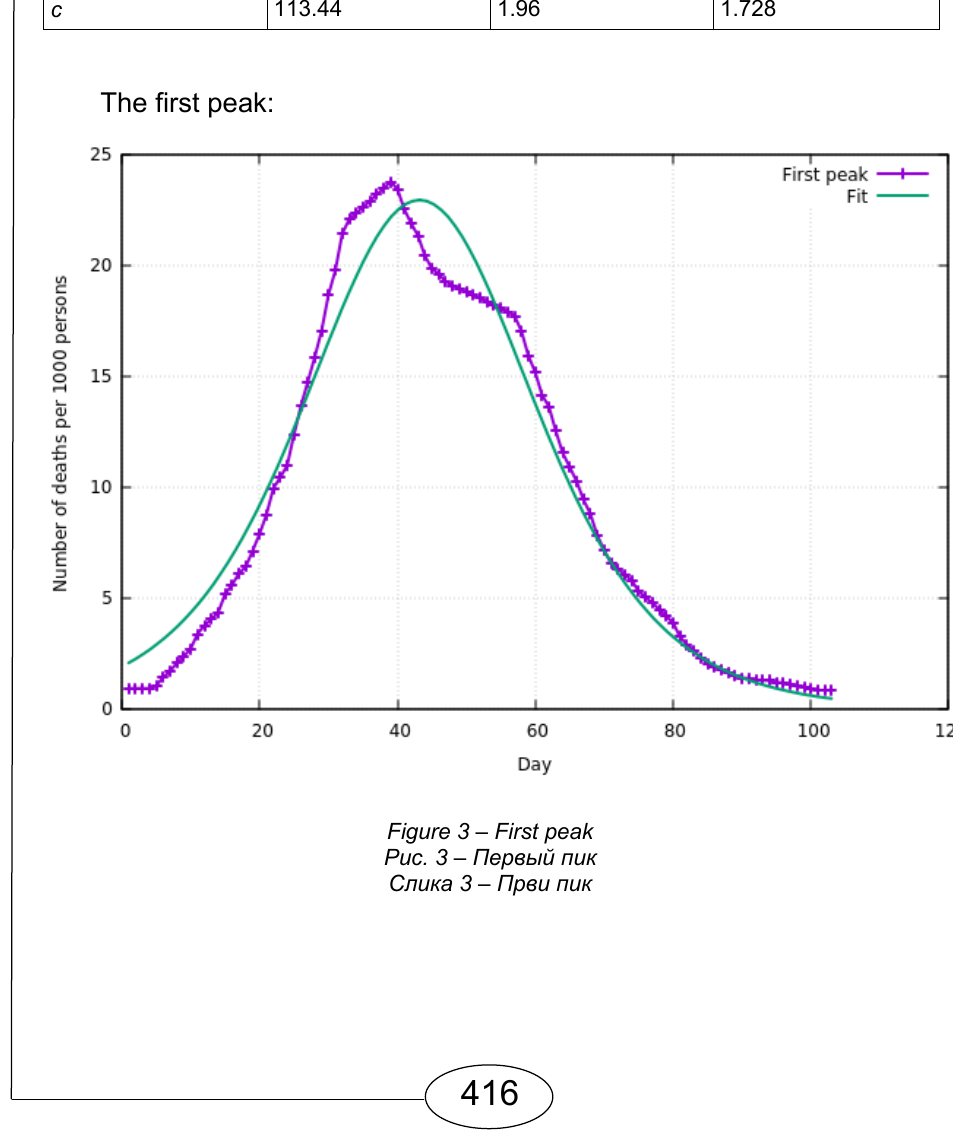
Figure 3 – First peak Рис . 3 – Первый пик Слика 3 – Први